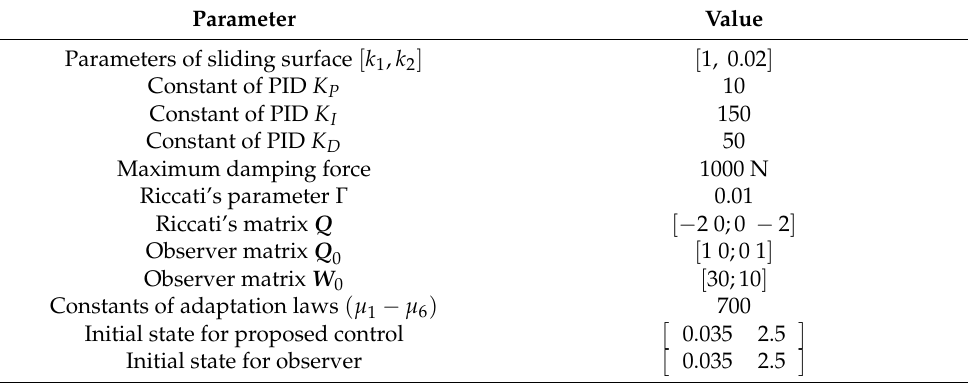
Table 2. Parameters of the seat suspension for Compared Controller 1 [23].